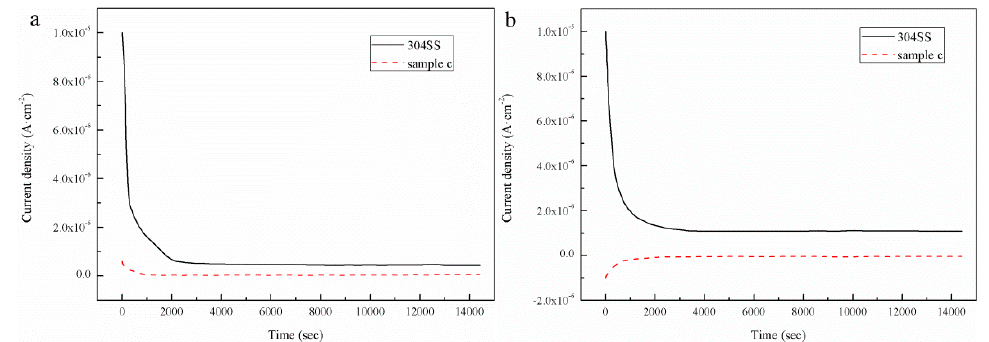
Figure 11. Potentiostatic polarization curves for sample C and the 304 stainless steel in a simulated PEMFC: ( a ) 0.6-V cathodic environment and ( b ) − 0.1-V anodic environment.